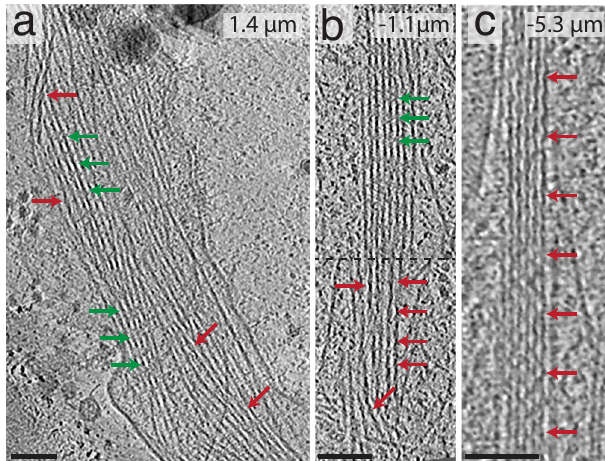
Fig. 5 Tomography of co fi lactin within fi lopodia. In all images, red arrows signify co fi lactin and green arrows show normal F-actin. The top-right corner of each image shows their distance from the lamellipodial veil (positive values are distal from the veil and negative values are proximal from it). a A 13.3 nm-thick tomographic slice where individual co fi lactin fi laments are scattered throughout a fascin-linked actin bundle. b 13.3 nm- thick tomographic slice through a prospective transition region where a clear boundary (represented by the dashed line) exists between the F-actin on top and the co fi lactin on bottom. c 13.3 nm-thick tomographic slice showing a pure co fi lactin bundle). Scale bars: 50 nm.